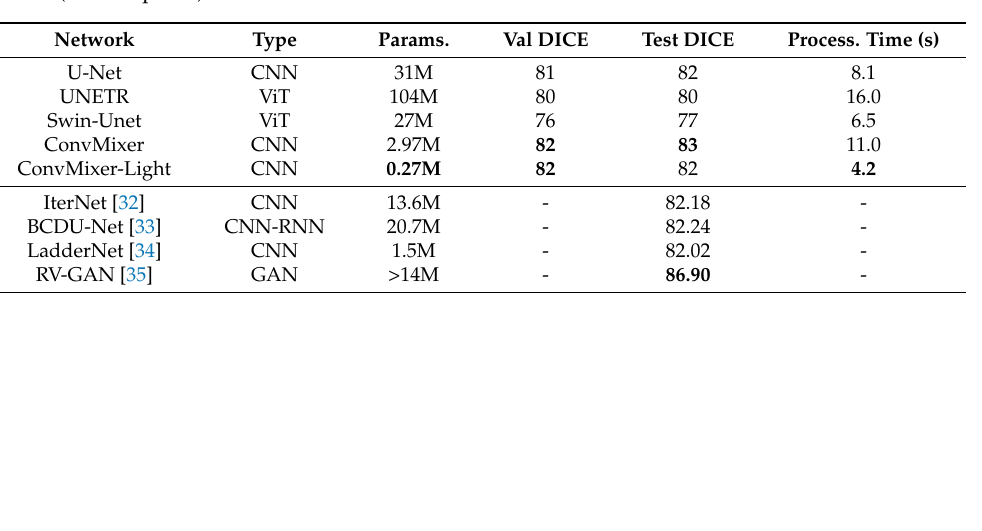
Table 3. Table summary of the results in validation and test DICE of the models we trained (top panel). The models and results of some of the leaders of the DRIVE dataset competition are also shown (bottom